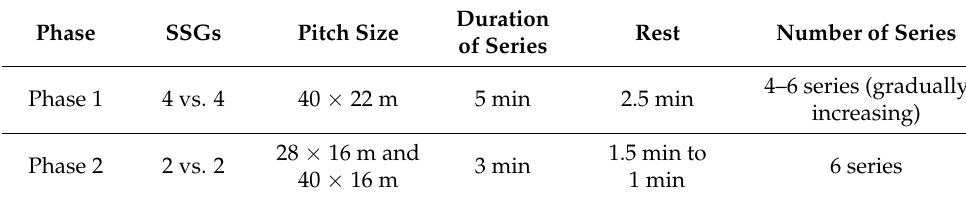
Table 1. Summary of variables used to adjust the volume and intensity of